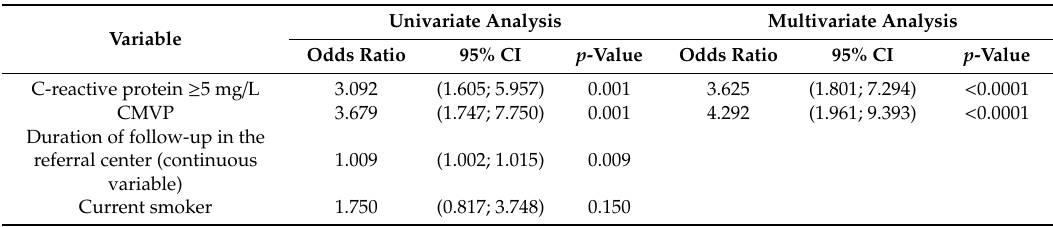
Table 3. Univariate and multivariate models with a low plasma vitamin C concentration as the dependent variable and predictor variables as the independent variables.